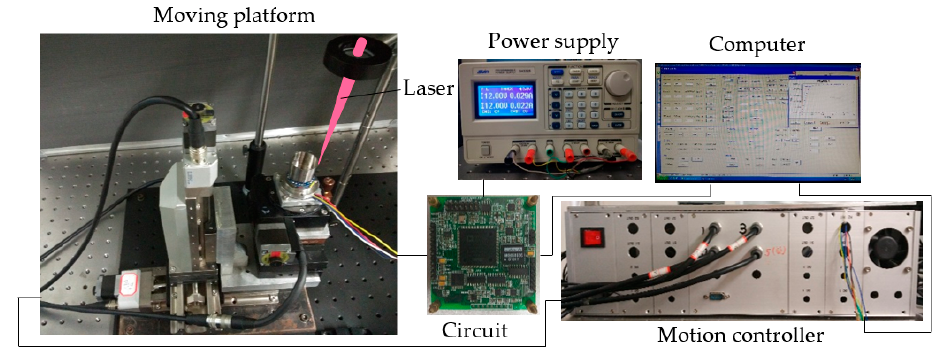
Figure 11. Experimental system.